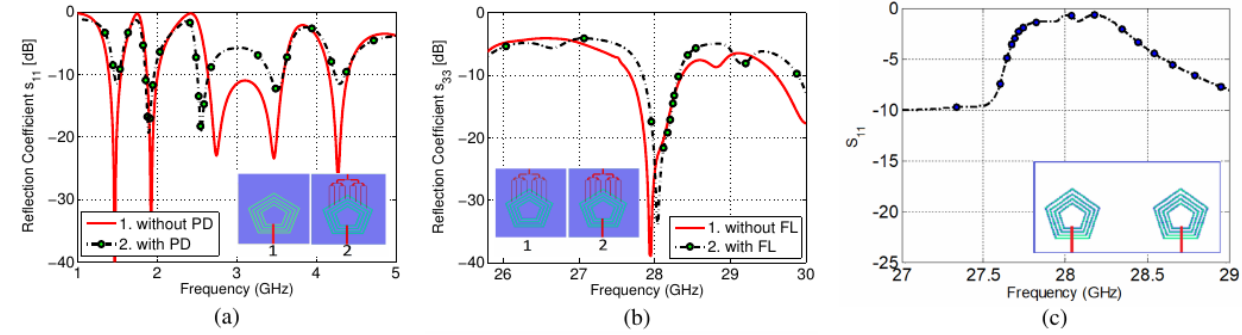
Figure 8. Input feed analysis: ( a ) S 11 with and without PD, ( b ) S 33 with and without the microstrip feed line, ( c ) Port − 1 excited at 28 GHz